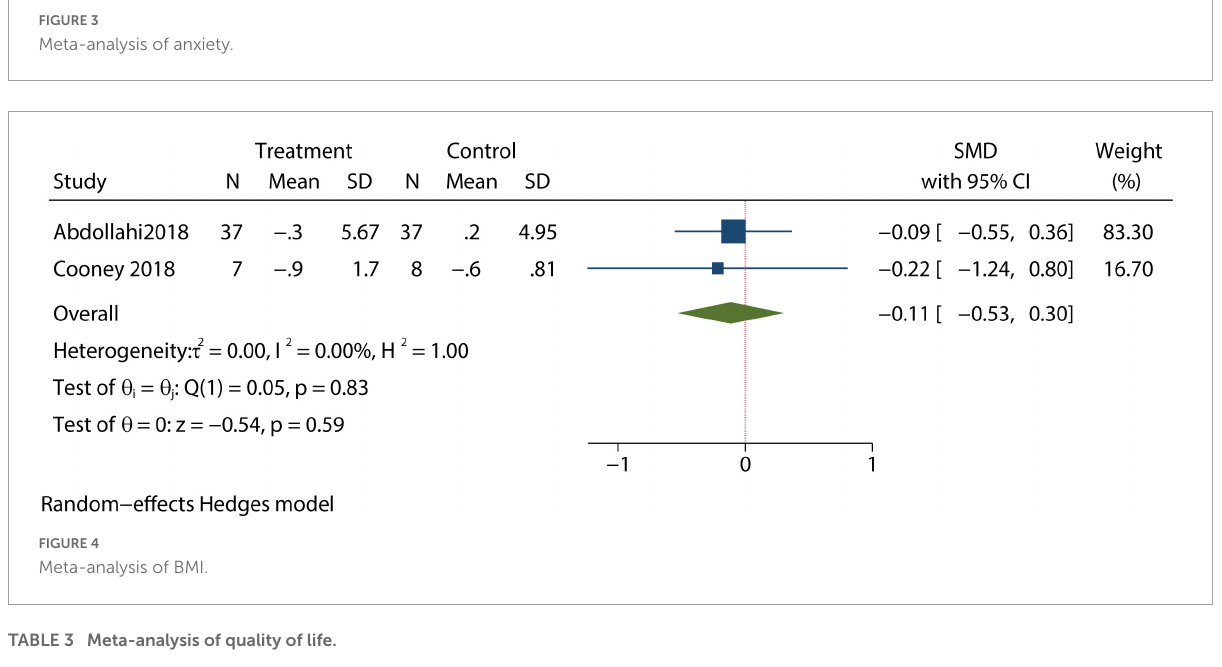
FIGURE3 Meta-analysis of anxiety.